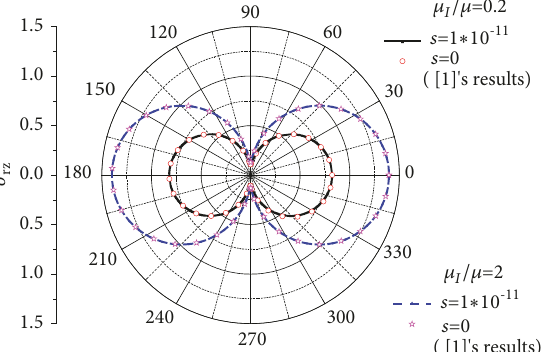
Figure 3: Comparison of the present and [1]’s results for the radial stress.